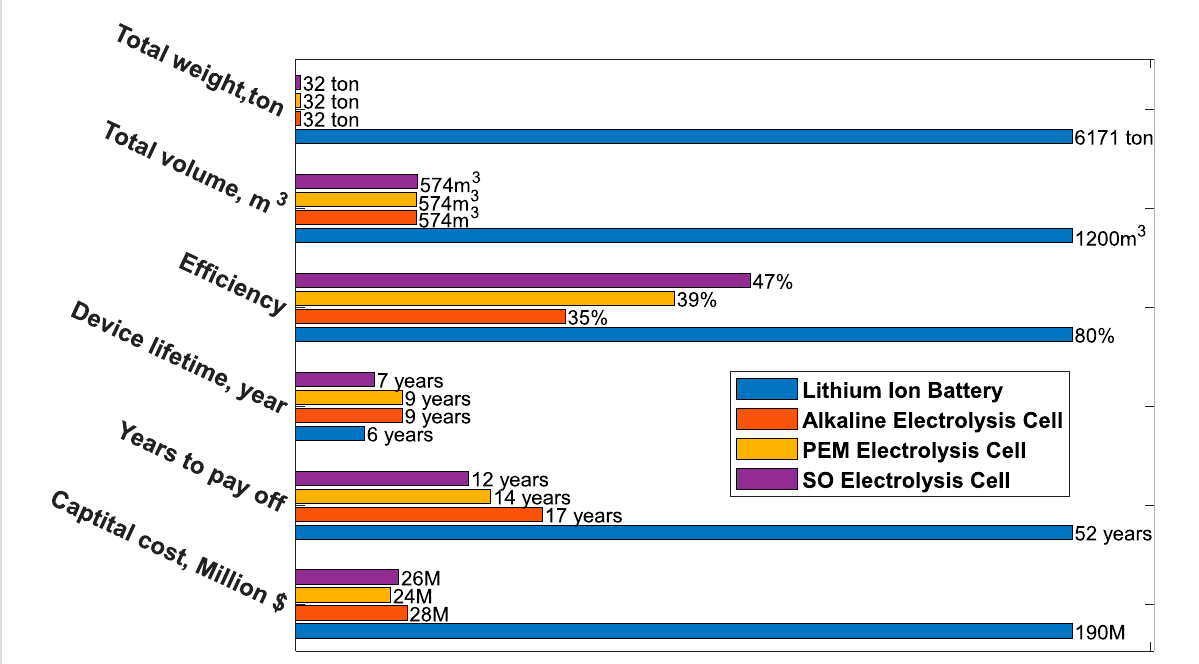
FIGURE 3 Technoeconomic analysis comparing lithium-ion battery energy storage to a proposed hydrogen storage approach for a 15 MW turbine and a 3-daysenergystoragesolution.Theresultsindicatethathydrogenismoreviableintermsofweight(32tonvs.6171ton),volume(574m 3 vs.1200 m 3